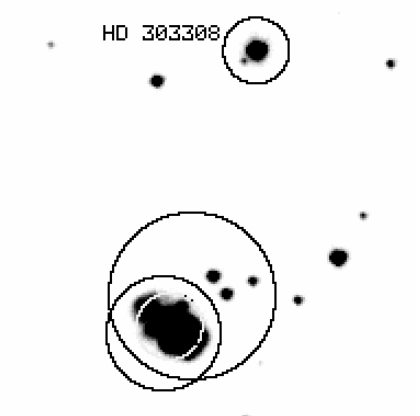
Fig. 5. Field of η Car with cal- ibration star HD 303308 (see